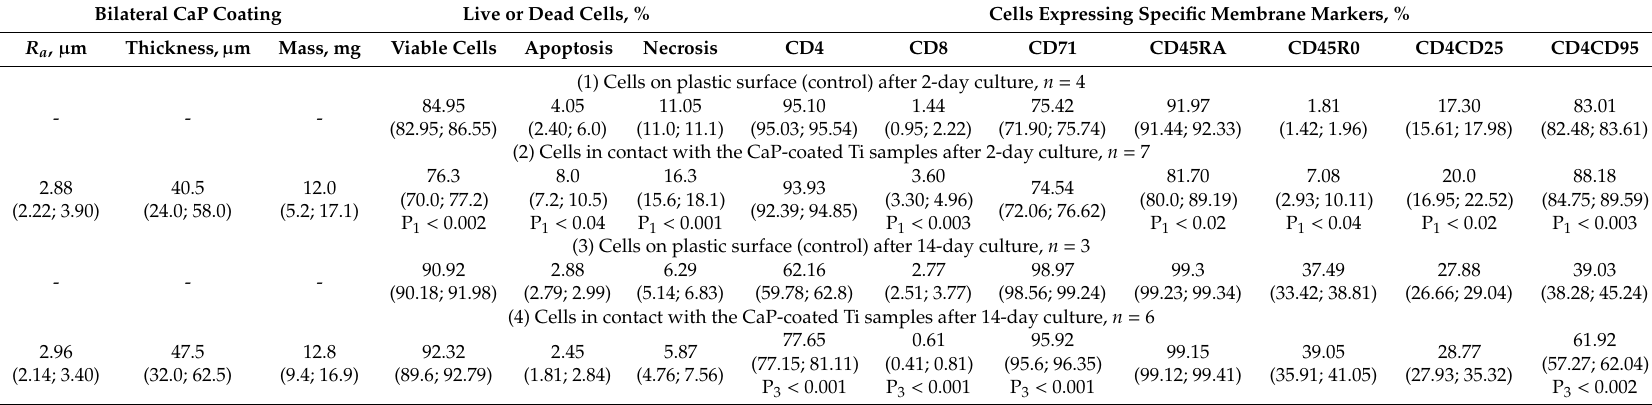
Table 3. Viability and immunophenotype of CD45 + CD3 + Jurkat T cells after di ff erent culture periods in the presence of the CaP-coated Ti samples; Me (Q 1 ; Q 3 ). Bilateral CaP Coating Live or Dead Cells, % Cells Expressing Specific Membrane Markers,